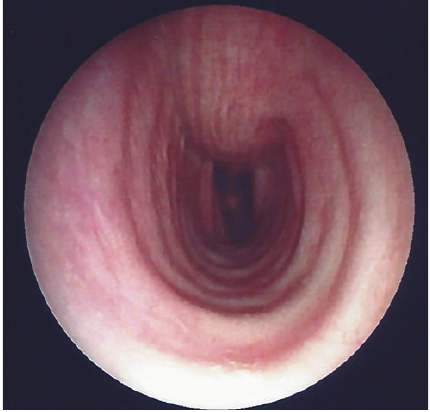
Figure 2: Bronchoscopic image of the patient’s normal tracheal mucosa.